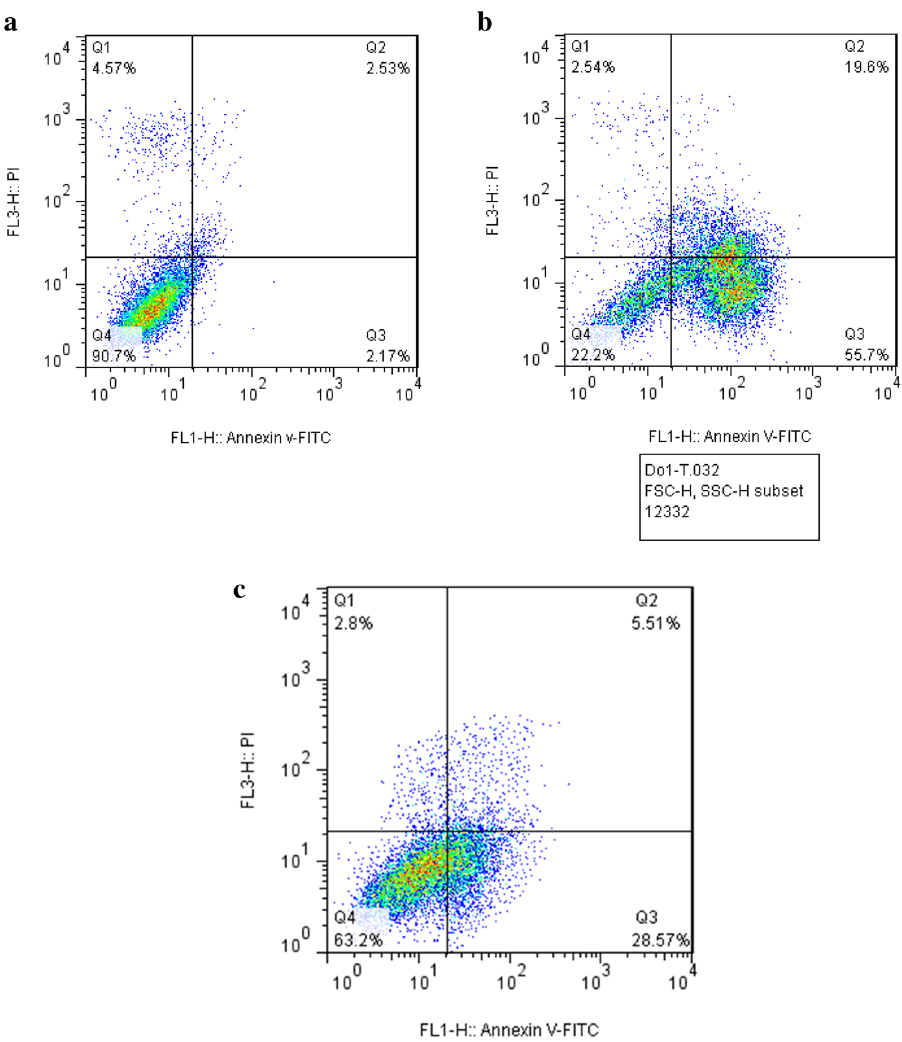
Figure 7. Flow cytometry of control ( a ), Bi 2 O 3 /Gln-TSC NPs treated cells ( b ) and Bi 2 O 3 /Gln NPs treated cells ( c ) (Q1: Necrotic cells, Q2: Late apoptosis, Q3: Early apoptosis, Q4: Live